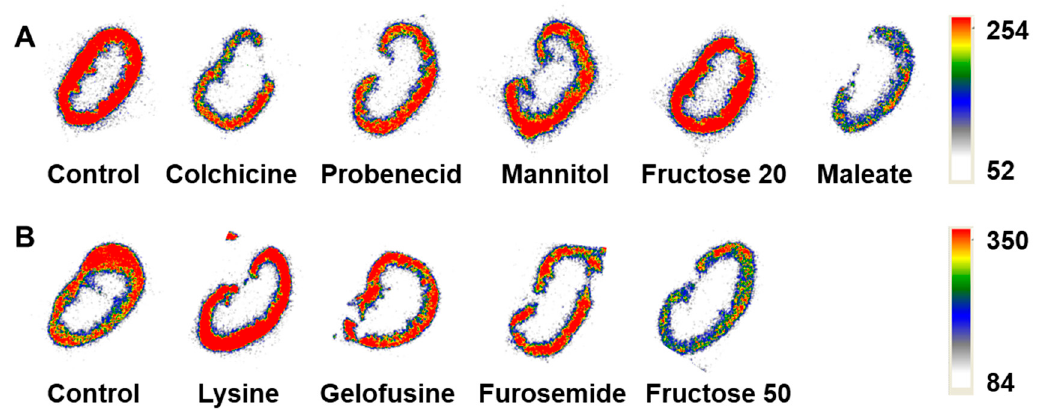
Figure 3. Representative ex vivo autoradiograms of the kidney sections of mice that were pre- or co-injected with ( A ) colchicine, probenecid, mannitol, fructose (20 mmol / kg), maleate or ( B ) lysine, gelofusine, furosemide, fructose (50 mmol / kg) before the injection of [ 99m Tc]Tc(CO) 3 -ADAPT6 in comparison with the control group that was injected with the radiolabeled protein